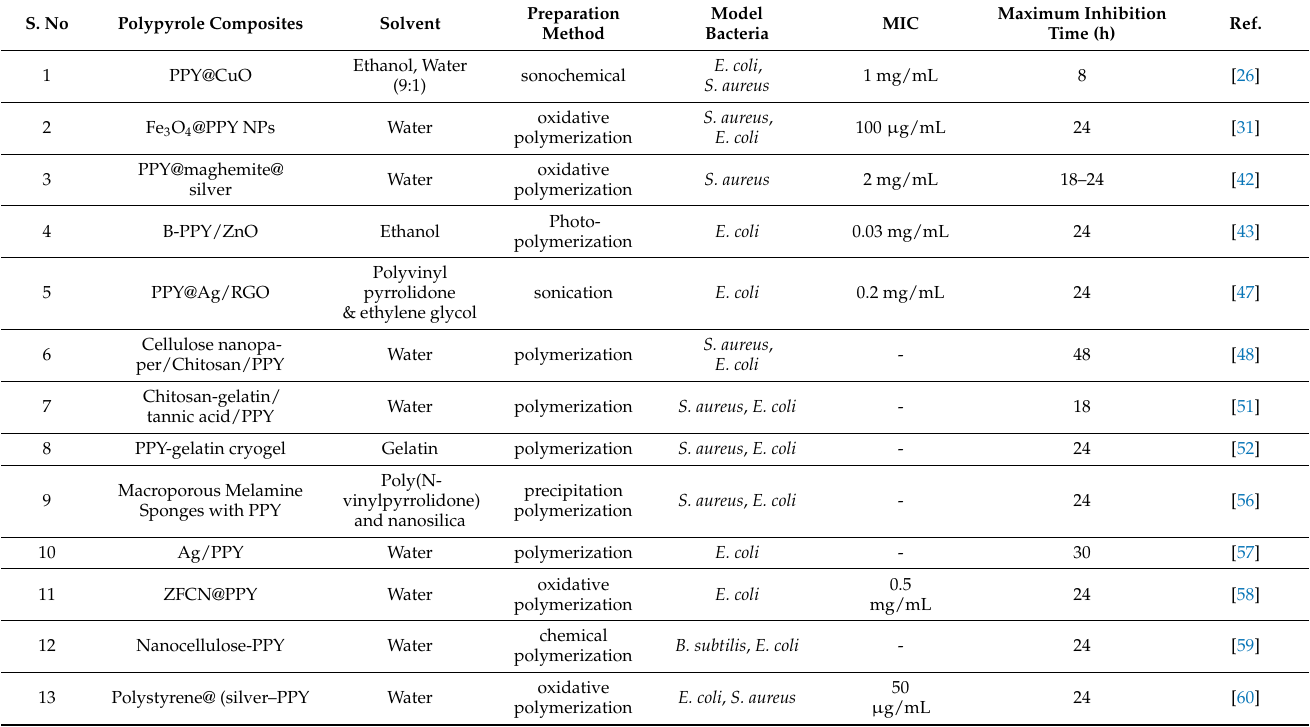
Table 1. Reported PPY-based composites for antimicrobial